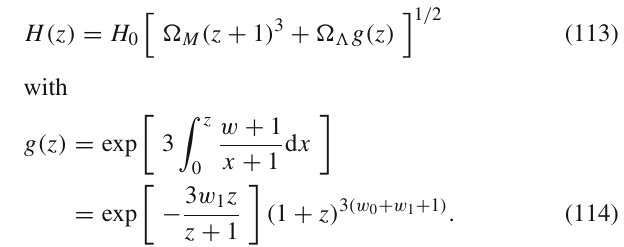
Fig. 2 The red-dotted curve represents the Hubble diagram for the (cid:3) CDM model with H = 0 . 68 ( 100km / s / Mpc ) , (cid:5) (cid:3) = 0 . 69 and 0 (cid:5) = 0 . 31 [90,91]. The blue-solid curve is the distance modulus M of the QWI model with f 0 = − 0 . 06 and H 0 = 0 . 70 ( 100km / s / Mpc ) . The green-dashed curve represents the best-fit result for the Chevalier–